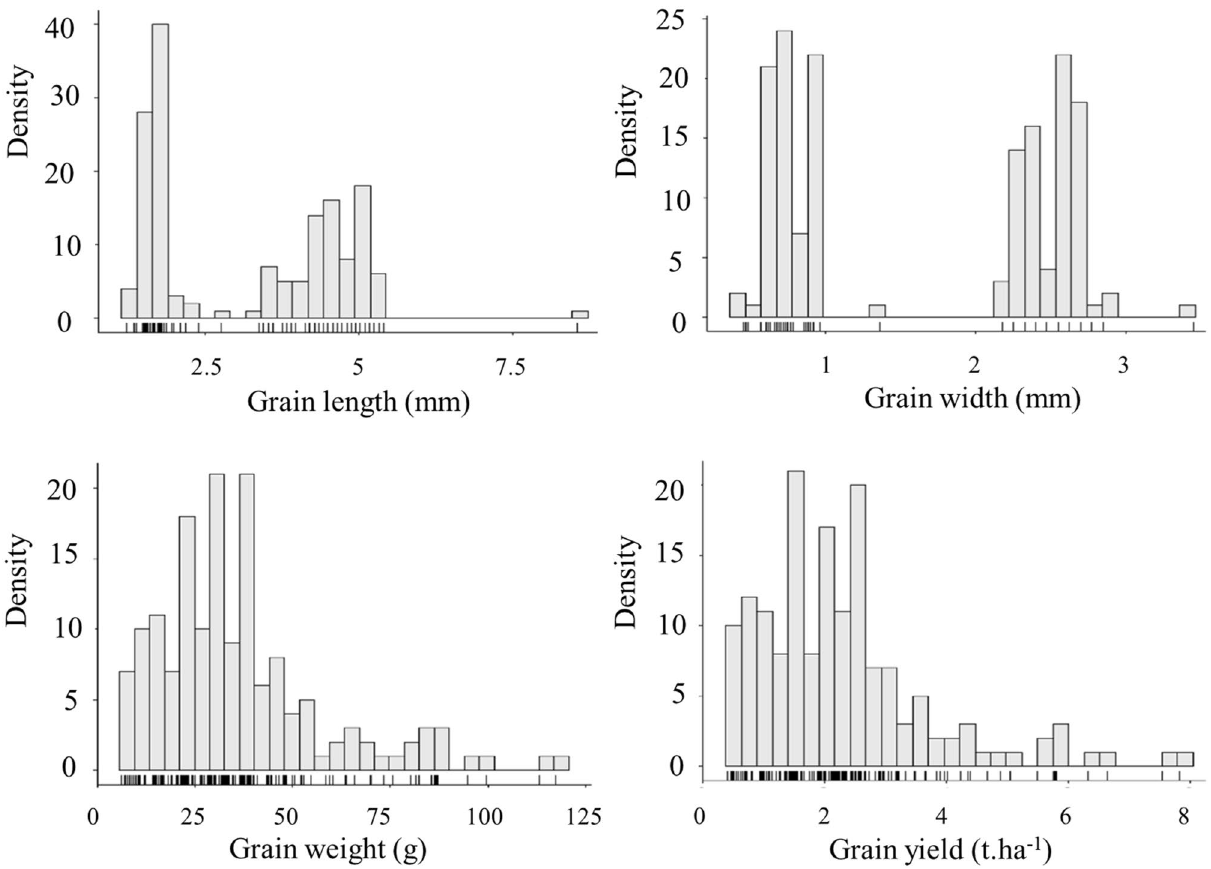
Figure 1. Distribution of phenotypes for grain length (upper left), grain width (upper right), grain weight (bottom left) and grain yield (bottom right). Histograms are based on the average trait value of each wheat line across the different environments. The bars under the histograms represent the density of individuals. Those phenotypes are referring only to the international panel of wheat and do not include the Canadian